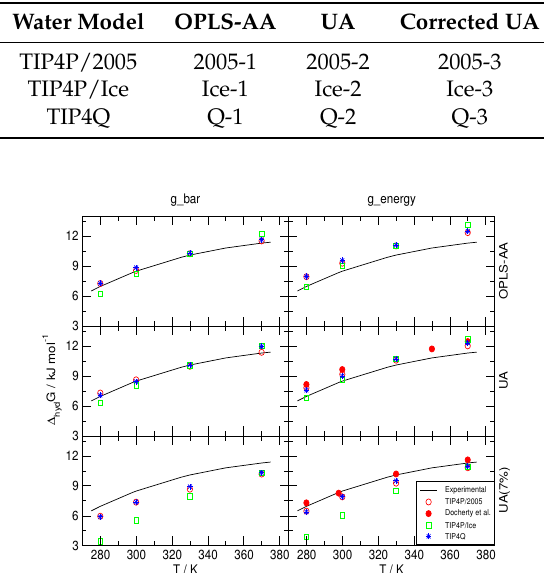
Figure 1. Comparison to the experimentally determined hydration free energy of methane (as reported in Reference [41]) of those obtained from MD simulations with Bennett’s Acceptance Ratio [46] (g_bar) and evenly spaced (g_energy) thermodynamic integration. OPLS-AA: All-atom force-field from Reference [40]; UA: United-atom model from Reference [41]; UA (7%): Same model with a 7% correction for the C − Øinteraction. The symbols were given sizes slightly larger than the corresponding standard